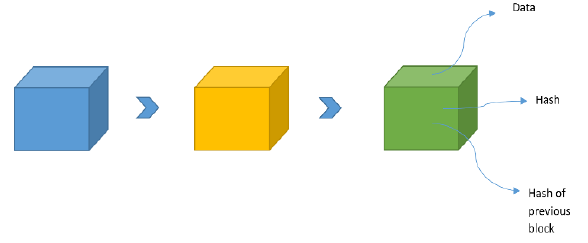
Figure 1. Blockchain architecture.